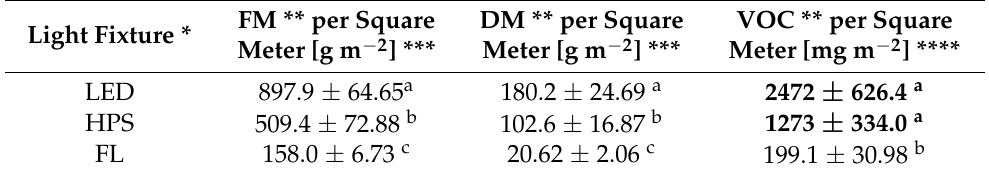
Table 3. Fresh and dry plant production as well as content of volatile fraction of thyme ( Thymus vulgaris L.) per m 2 under three supplemental lighting systems.